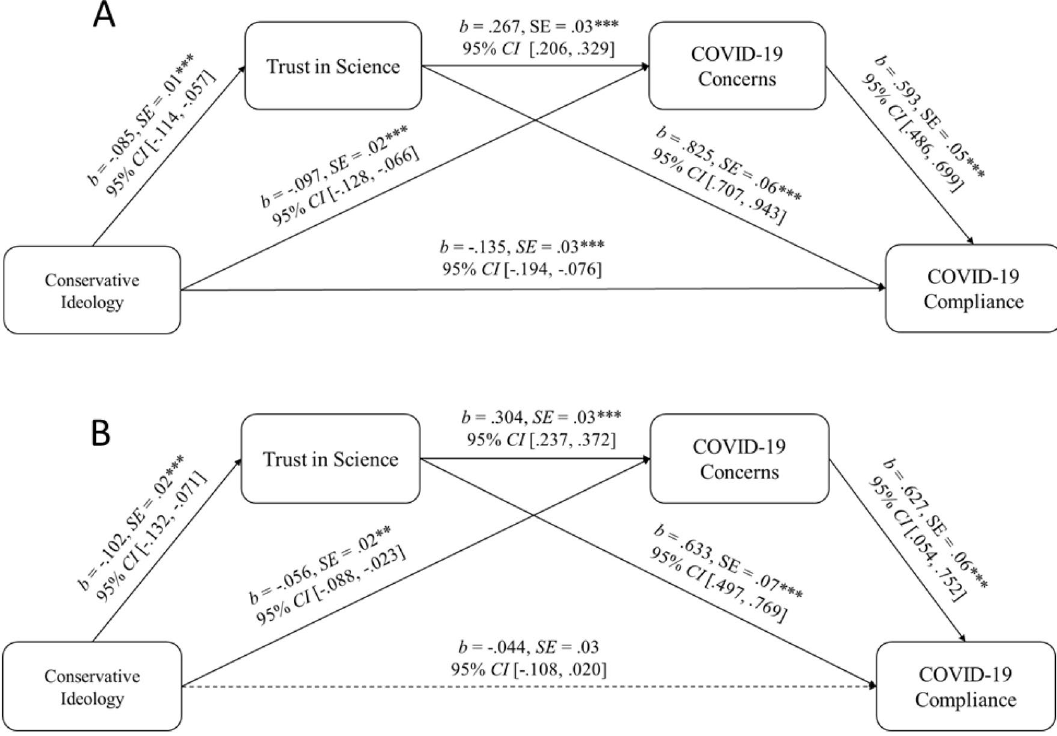
Figure 2. ( A , B ). Indirect effect tests (Process Macro, Model 6 55 , 10,000 bootstrapped samples) of conservative and age, in both Study 2a ( A , top) and 2b ( B , bottom). Figure was constructed in Microsoft PowerPoint with manually input data copied from SAS 9.4 output. Note: ** p < .01; *** p <